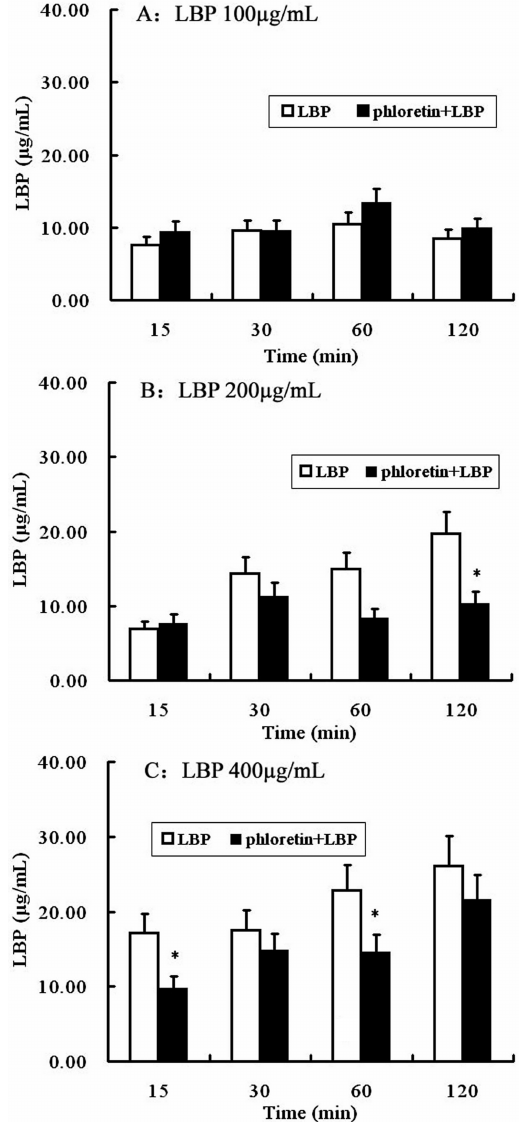
Figure 8. The uptake of LBP after GLUT-1 inhibition in Caco2 cells. ( A ) Caco2 cells were treated with LBP (100 μ g/mL) for 120 min after phloretin (2 mmol/L) pretreating; ( B ) Caco2 cells were treated with LBP (200 μ g/mL) for 120 min after phloretin (2 mmol/L) pretreating; ( C ) Caco2 cells were treated with LBP (400 μ g/mL) for 120 min after phloretin (2 mmol/L) pretreating. The data are presented as the mean ± SD ( n = 3). The asterisk indicate a significant difference among samples, * p < 0.05 (Student’s paired t -test).